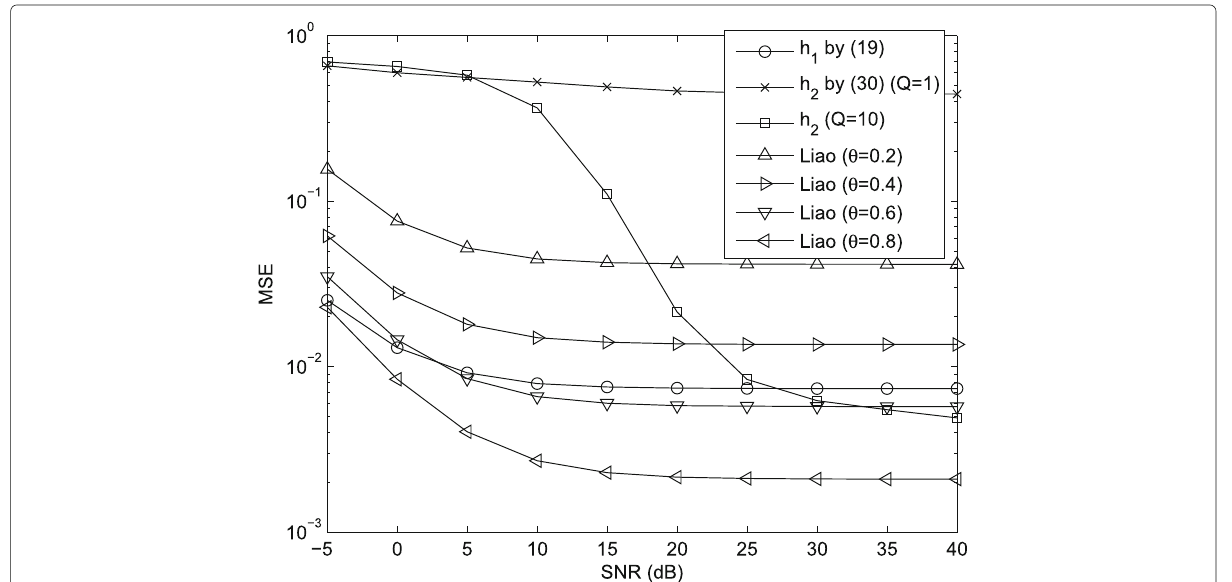
Fig. 6 Comparison of the normalized MSE for K = 50. We compare the normalized MSE performances of our method with the method proposed by Liao et al. in [34]. The parameter θ in Liao’s algorithm is set to 0.2, 0.4, 0.6, and 0.8. The number of received blocks is K =